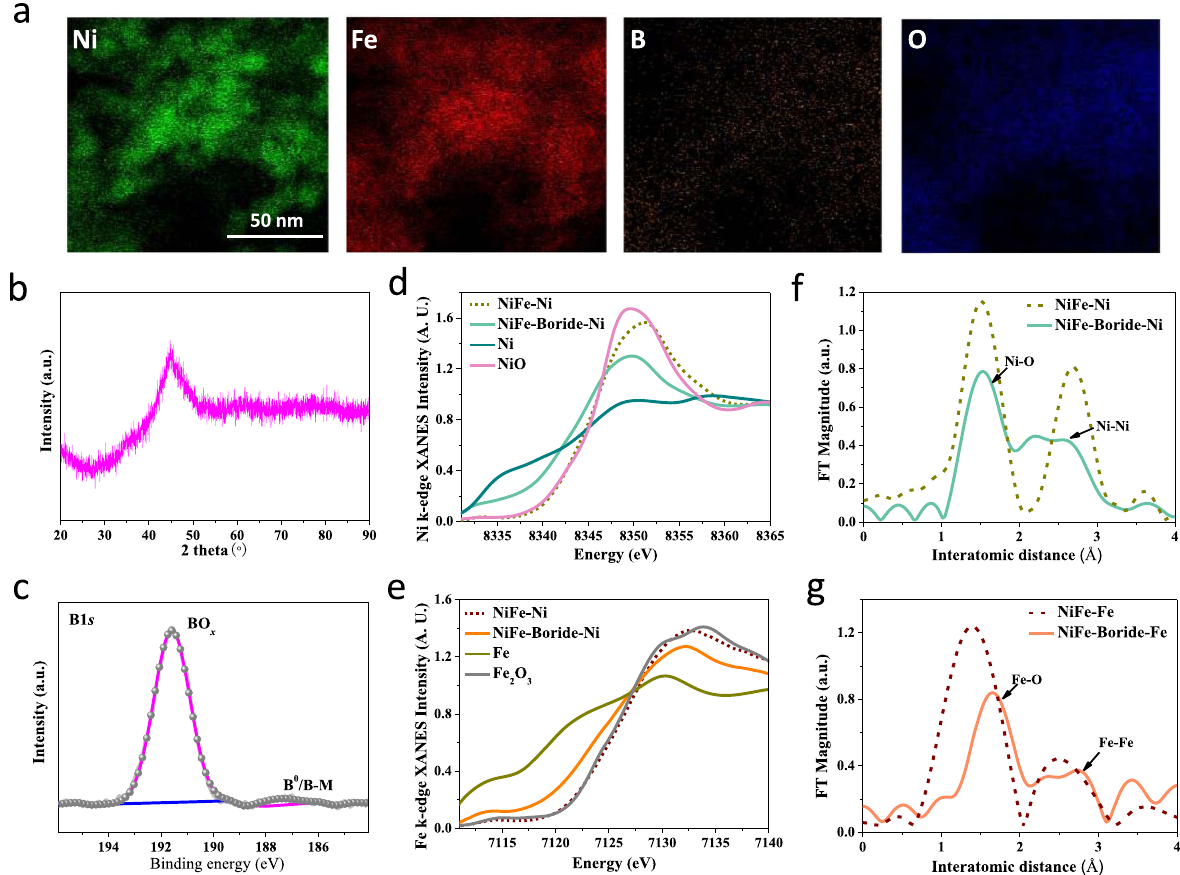
Fig. 2 Characterization of the morphology and composition of NiFe-Boride catalyst. ( a ) Elemental mapping analysis, showing the uniform, uncorrelated spatial distribution of Ni, Fe, B and O. ( b ) XRD patterns. ( c ) B 1 s XPS spectrum of fresh NiFe-Boride sample. The Ni and Fe K -edge XANES ( d ) and ( e ) and EXAFS ( f ) and ( g ) data for fresh NiFe-Boride and control